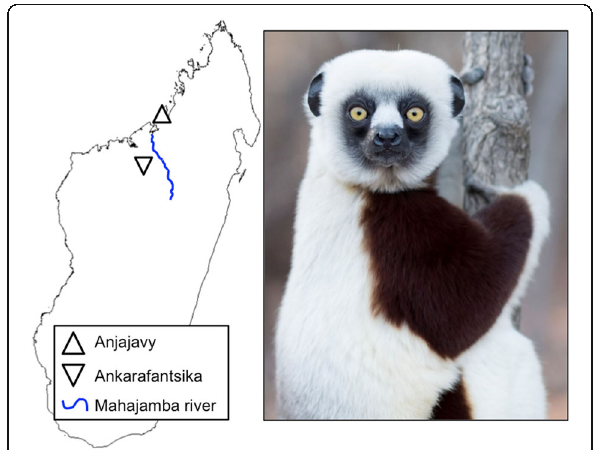
Fig. 1 Map of Madagascar highlighting the two field sites, including the Anjajavy Protected Area (up triangle) and Ankarafantsika National Park (down triangle), separated by the Mahajamba river (blue line), and photo of the study species, the Coquerel ’ s sifaka ( Propithecus coquereli ). Photo by Sara